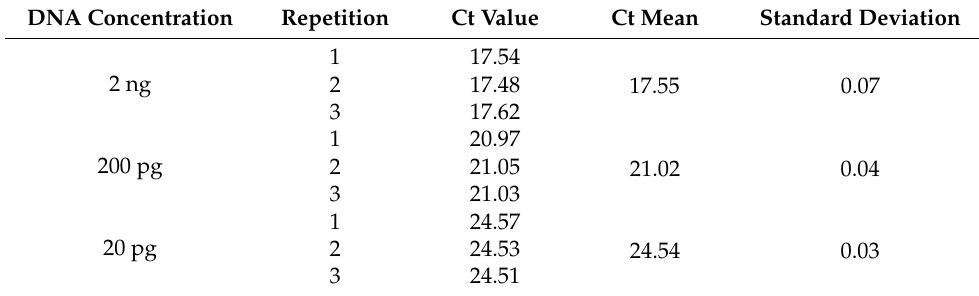
Table 5. Sensitivity results observed with qPCR Taqman 2b on a Standard curve of P. punjabense SS95 T